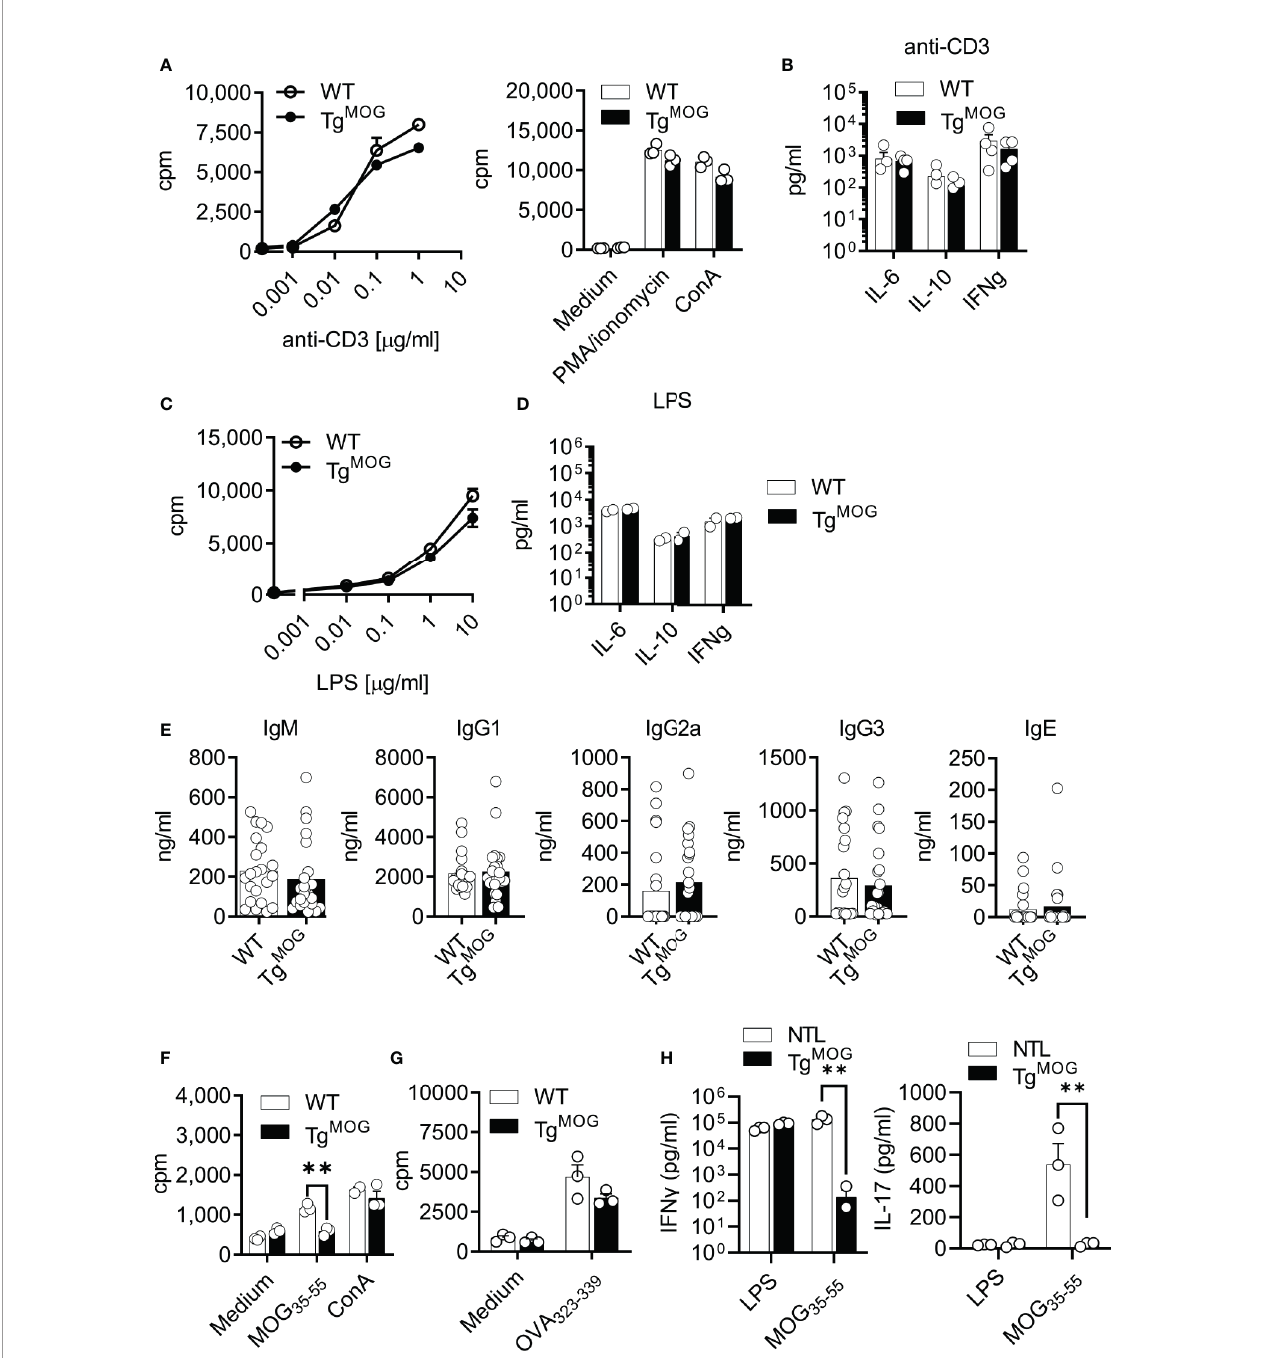
FIGURE 2 | Immune responses in Tg MOG mice. (A) , Proliferation of splenocytes from WT or Tg MOG mice in response to polyclonal stimulants anti-CD3, PMA/ ionomycin, and ConA. Each circle represents an individual replicate. (B) , Cytokine (IL-6, IL-10, and IFN g ) secretion by splenocytes in response to anti-CD3 stimulation. Each circle represents an individual mouse. n = 4 per group. (C) , Proliferation of splenocytes in response to LPS stimulation. (D) , Cytokine (IL-6, IL-10, and IFN g ) secretion by splenocytes in response to LPS stimulation. Each circle represents an individual mouse. n = 2 per group. (E) , Total IgM, IgG1, IgG2a, IgG3 and IgE immunoglobulin titers in the sera of Tg MOG (n = 23) or WT (n = 22) mice were measured by ELISA. (F, G) Proliferation of splenocytes from MOG 35-55 (F) or OVA 323-339 (G) immunized WT or Tg MOG mice. Each circle represents an individual replicate. **P = 0.0016 (Two-way ANOVA). (H) , Cytokine (IFN g and IL-17) secretion of splenocytes in response to LPS or MOG 35-55 stimulation. **P = 0.0043, **P = 0.0094 (Two-way ANOVA). n = 3 per group. (A – D, F, G) , Representative data from two independent experiments is